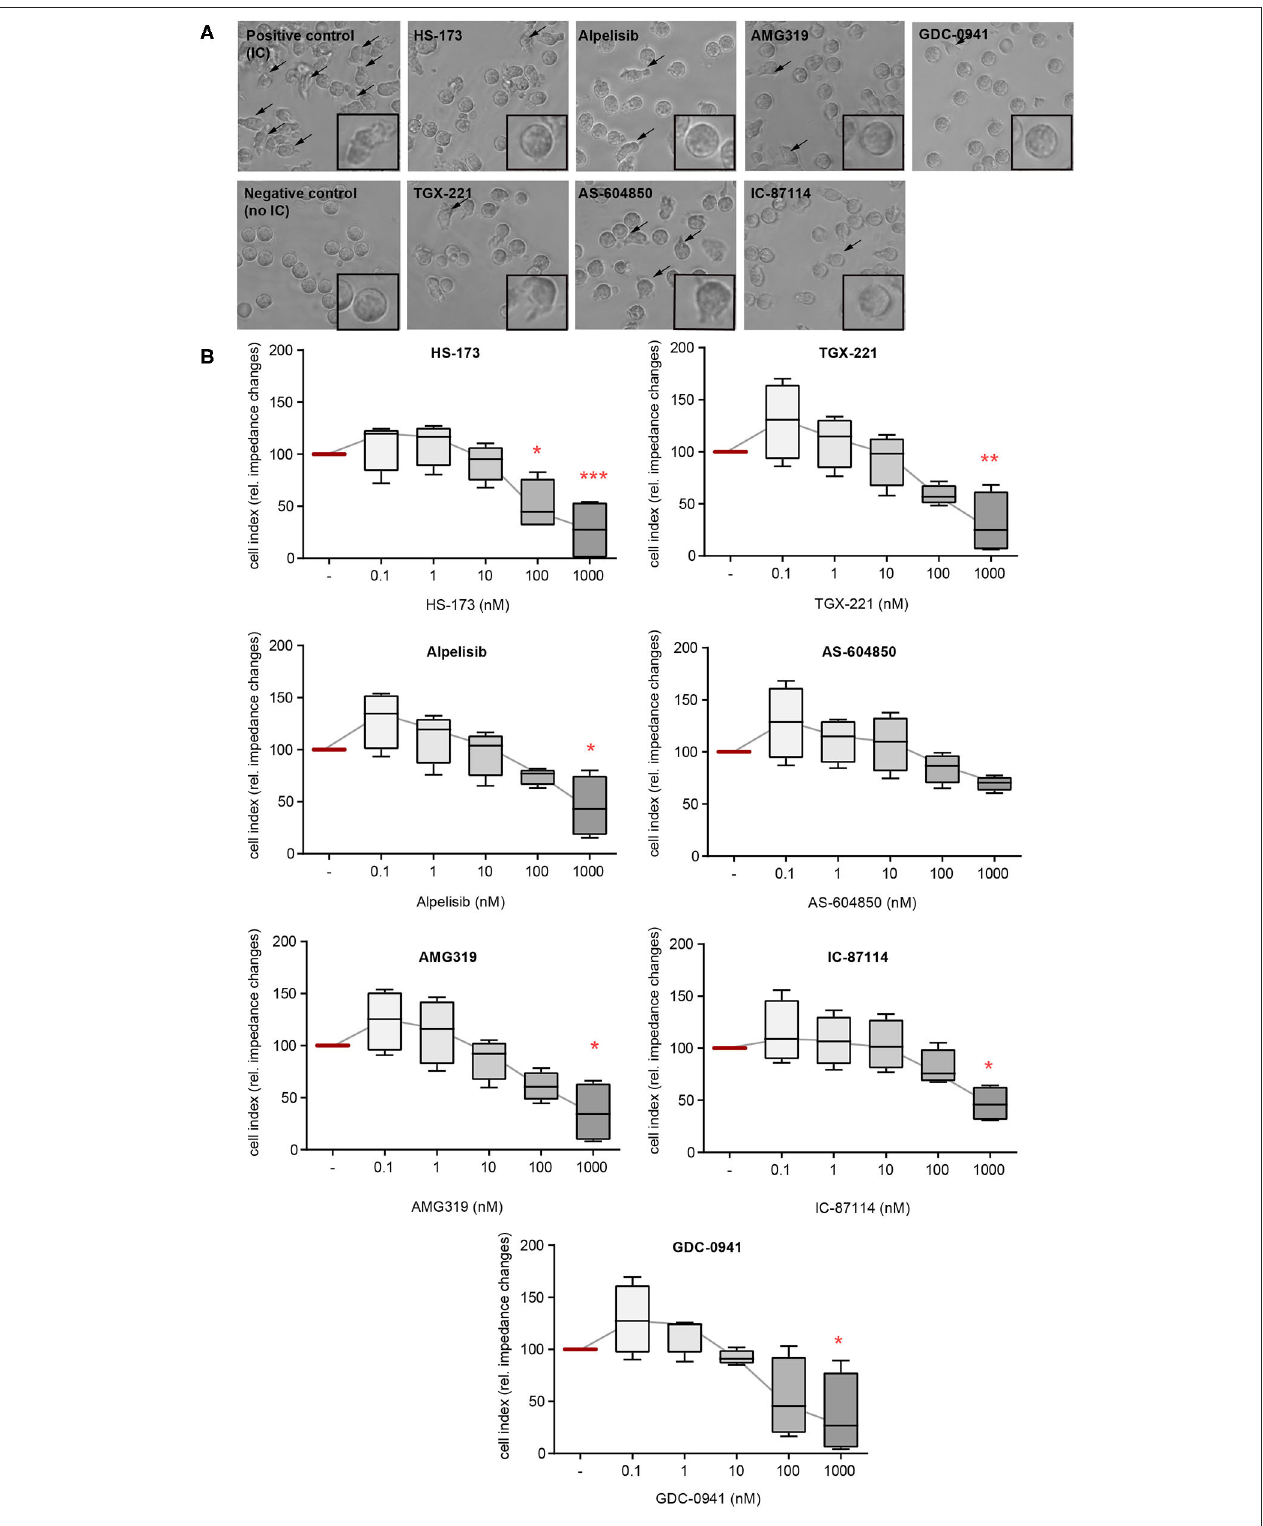
FIGURE 2 | IC-induced spreading of PMNs mainly depends on PI3K δ . Freshly isolated human blood PMNs were activated with immobilized ICs in the presence of either one of the PI3K isoform-selective inhibitors. (A) Microscopic appearance of PMNs 2h after IC-stimulation. IC-stimulated PMNs show clear spreading on surface (arrows). The highest concentration of all inhibitors (1 µ M) reduced the adhesion of PMNs. (B) Spreading was monitored live for 2h and the area under curve (AUC) was analyzed. Data are shown as Tukey’s box-and-whisker plots. n = 4. ANOVA on ranks (Kruskal-Wallis) was applied followed by a Bonferroni t -test for multiple comparisons. Data were normalized to IC-stimulated cells. * p < 0.05, ** p < 0.01, *** p < 0.001.